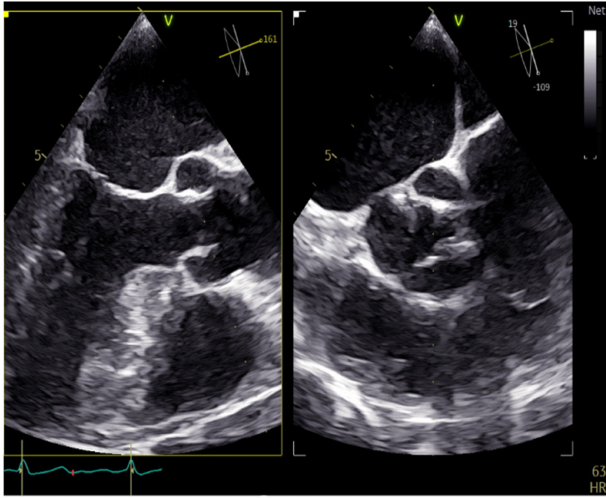
Figure 3. Transesophageal view long axis of the mitral valve and short axis of the aortic